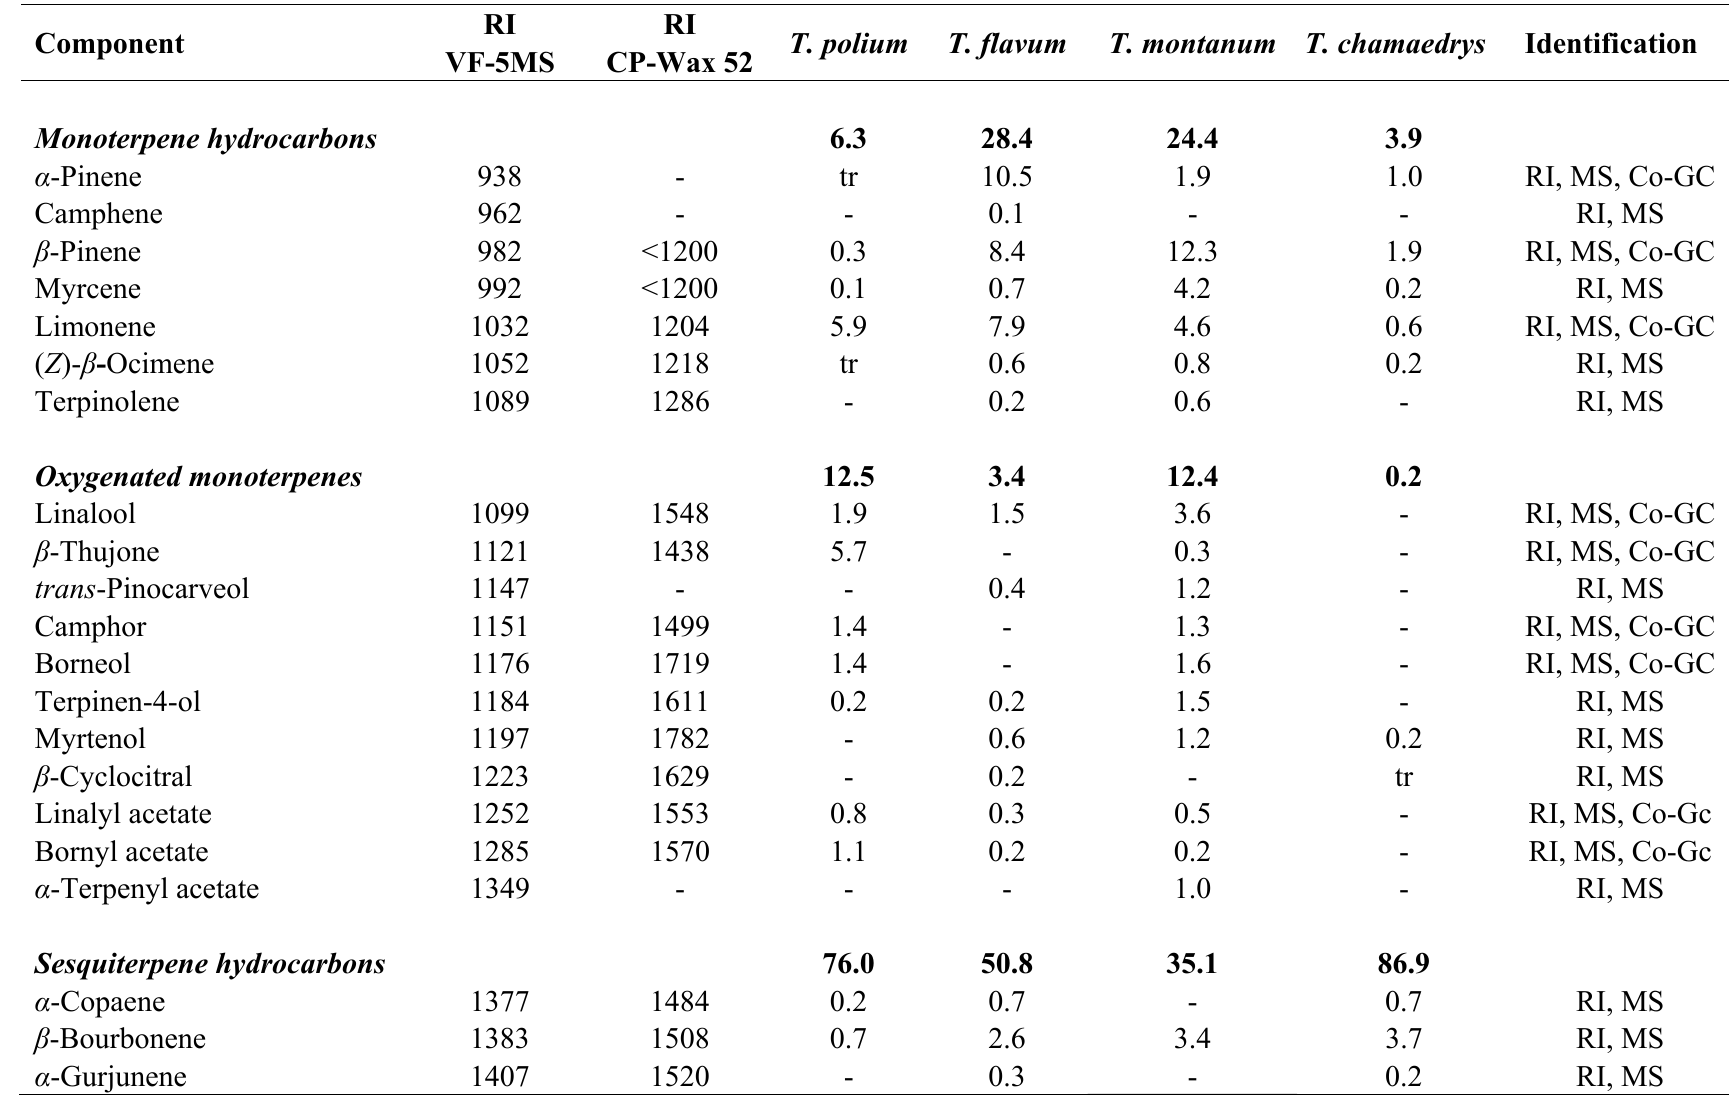
Table 1. Phytochemical composition (%) of essential oils of T. polium , T. flavum, T. montanum and T.